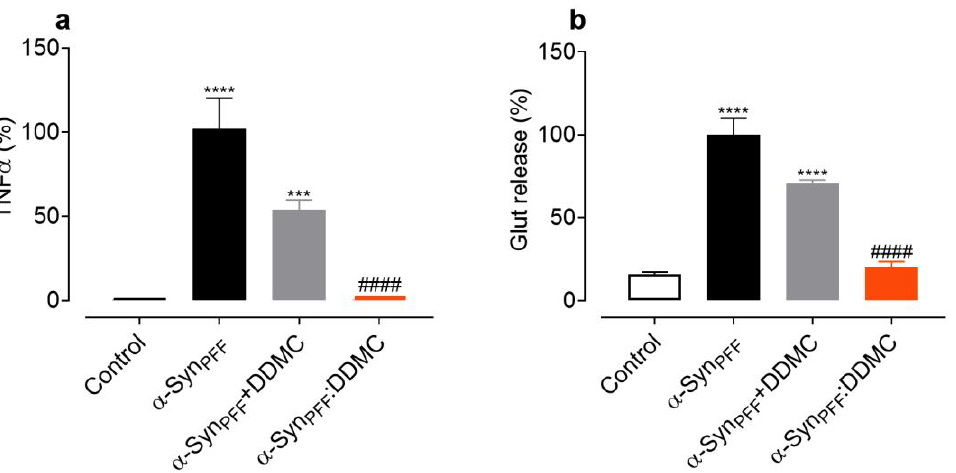
Figure 5. DDMC mitigates the inflammogenic properties of α -Syn amyloid-like fibrils. ( a ) TNF α and ( b ) Glut release from microglial cells undergoing (i) no treatment (control) or an exposure to (ii) α -Syn PFF ; (iii) α -Syn PFF together with 0.7 µ M DDMC ( α -Syn PFF +DDMC) or to iv) α -SynPFF formed in the presence of 10 µ M DDMC ( α -SynPFF:DDMC) with subsequent dialysis. Bars